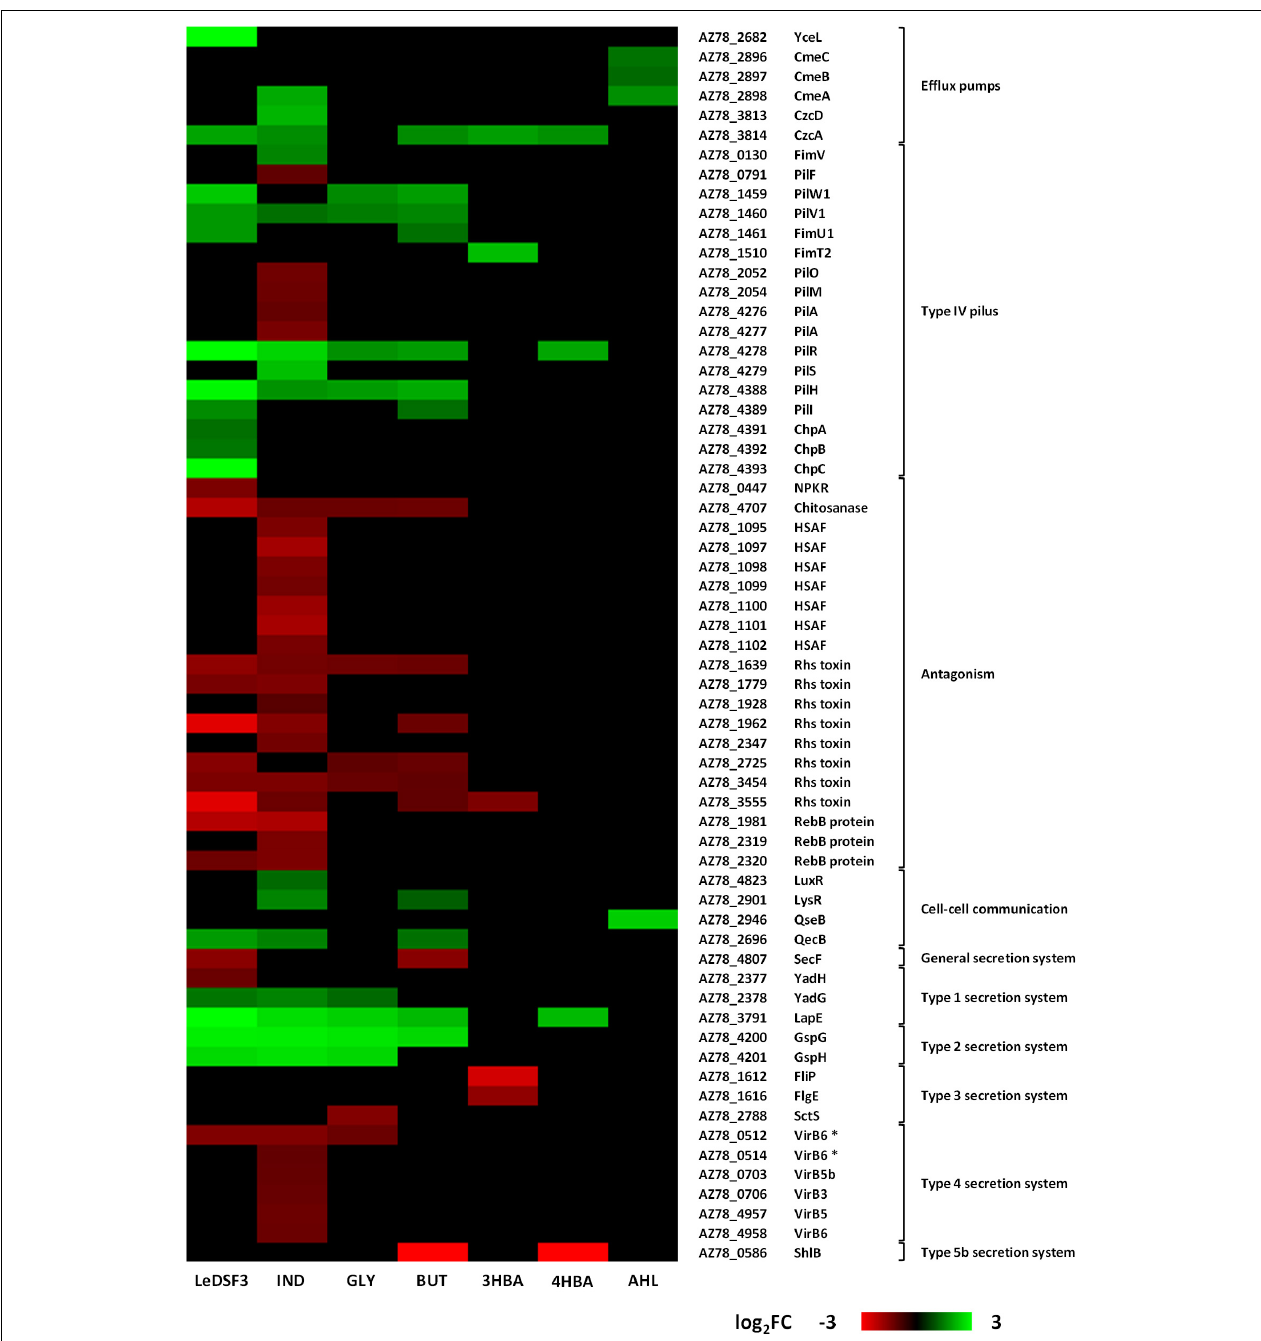
FIGURE 3 | Heatmap based on log2-fold change (FC) of Lysobacter capsici AZ78 genes differentially expressed in response to diffusible communication signals and related to efflux pumps, type IV pilus, antagonism, cell–cell communication systems, and secretion systems. HSAF, heat-stable antifungal factor. VirB6 * represents duplicate gene pairs located through AZ78 genome. LeDSF3, 13-methyltetradecanoic acid 50 µ M; IND, indole 500 µ M; GLY, glyoxylic acid 0.01 µ M; BUT, 2,3-butanedione 0.01 µ M; 3HBA, 3-hydroxybenzoic acid 30 µ M; 4HBA, 4-hydroxybenzoic acid 50 µ M; AHL, mix of N -acyl-homoserine lactones 20 µ